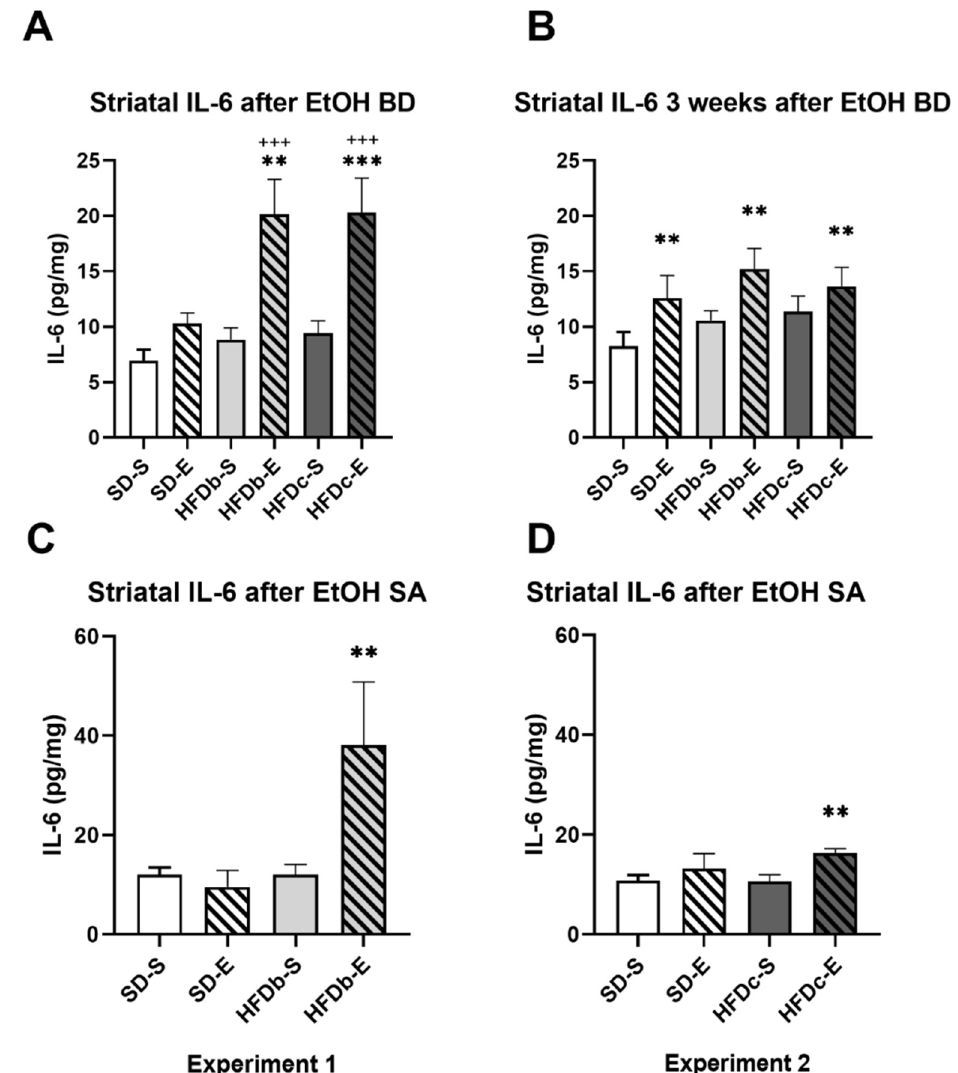
Figure 3. Intermittent ethanol intake during adolescence and high-fat diet (HFD) increase IL-6 levels in the striatum. The columns represent the mean and the vertical lines ± SEM of concentration levels of IL-6 (pg/mg protein) ( A ) after ethanol binge drinking (BD) during adolescence, ( B ) 3 weeks after the last ethanol injection and ( C ) after the end of the oral self-administration (SA) procedure in the groups with food deprivation and ( D ) in the groups without food deprivation *** p < 0.001, ** p < 0.01 with respect to the corresponding non-ethanol-treated groups; +++ p < 0.001 with respect to the corresponding standard diet fed group.